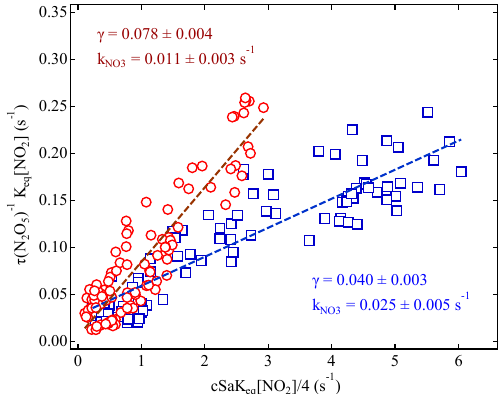
2 O 5 steady-state lifetimes ac- cording to Eq. (5) for two cases observed on the nights of 2 and are 21 August 2014. The best fit values of γ and k NO 3